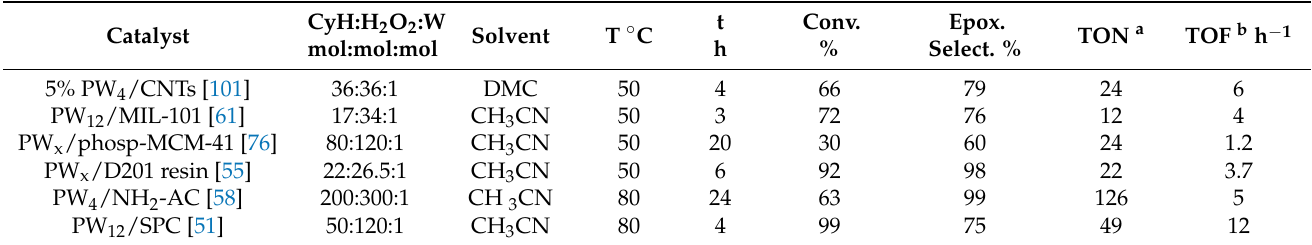
Table 5. Comparison of the catalytic performance of 5 wt. % PW 4 /CNT with other reported heterogeneous catalysts based on phosphotungstates in CyH